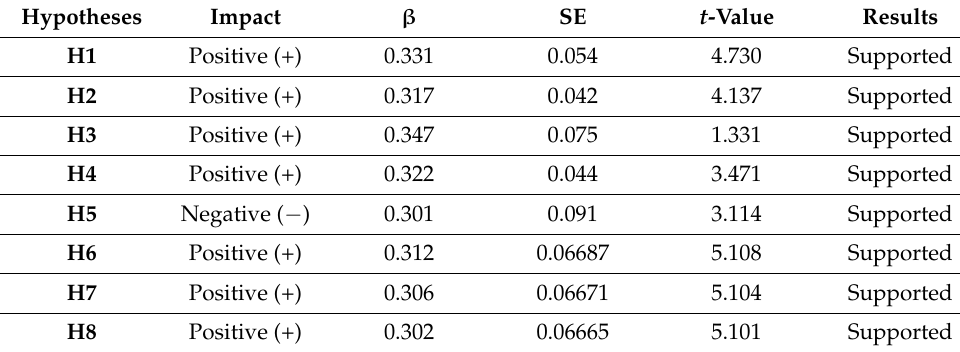
Table 3. Results of structural equation modelling